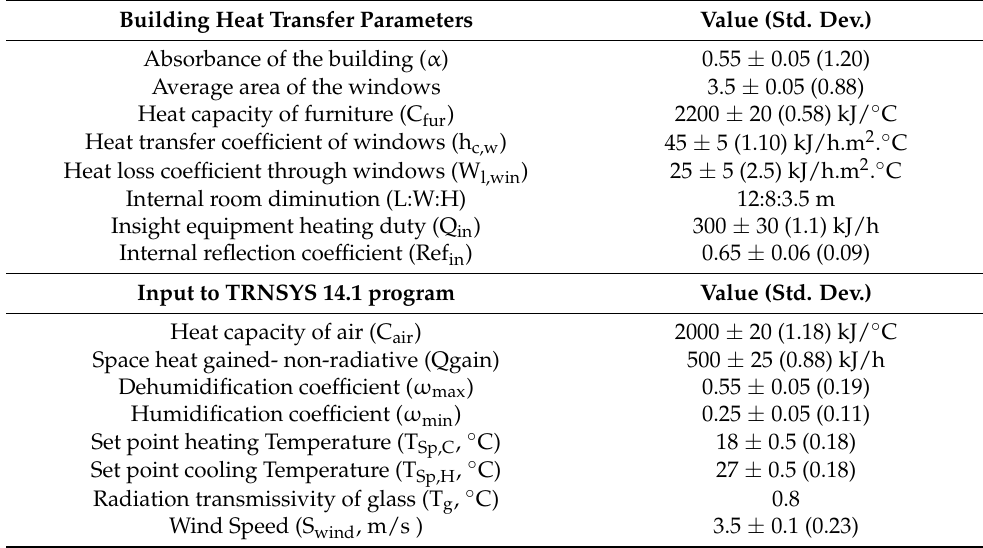
Table 1. Building heat transfer parameters and the input to TRNSYS 14.1